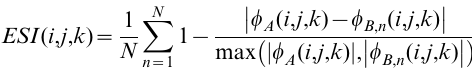
Figure S1 Complement regulators and receptors bind the acidic ‘‘hot-spot’’ of complement C3d. Cumulative electrostatic similarity distribution for 24 homologues projected onto the surface of human C3d (same as Figure 3A) [blue – green – red; low to high similarity] with host ligands superimposed. Ribbon representations are used for the host ligands: FH 4 – white (PDB: 2WII); FH 19/ 20 – gray (PDB: 2XQW); CR2 – black (PDB: 3OED). Two rotations of C3d (180 degrees about the y-axis) are provided to show the two electrostatic ‘‘hot-spots’’: (A) CR2-face and (B) thioester-face. Figure S2 Pathogenic inhibitors of the complement system target the conserved electrostatic ‘‘hot-spots’’ of complement C3d. Cumulative electrostatic similarity distribution for 24 homologues projected onto the surface of human C3d (same as Figure 2B) [blue – green – red; low to high similarity] with S. aureus virulence factors superimposed. Ribbon representations are used for the S. aureus virulence factors: Ehp – white (PDB: 2NOJ); Efb-C – gray